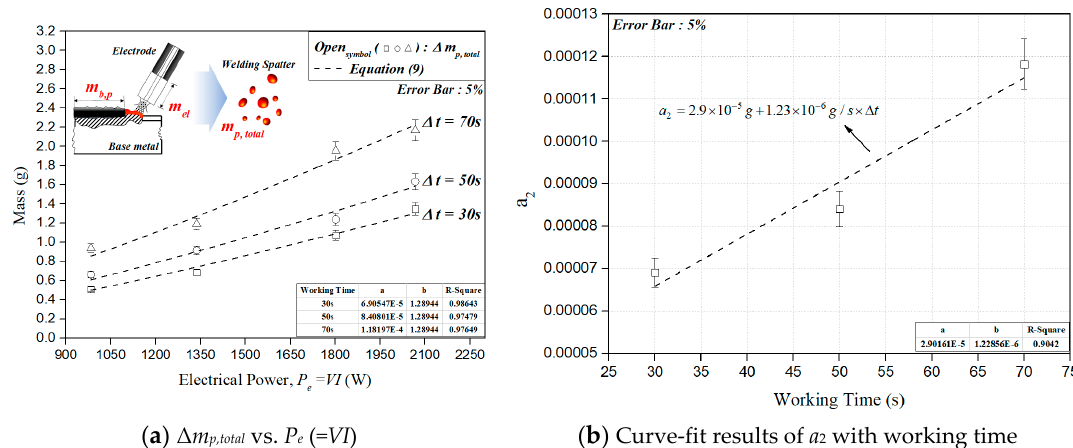
Figure 5. Effects of electrical power on the total mass of welding particles at welding times of 30 s, 50 s, and 70